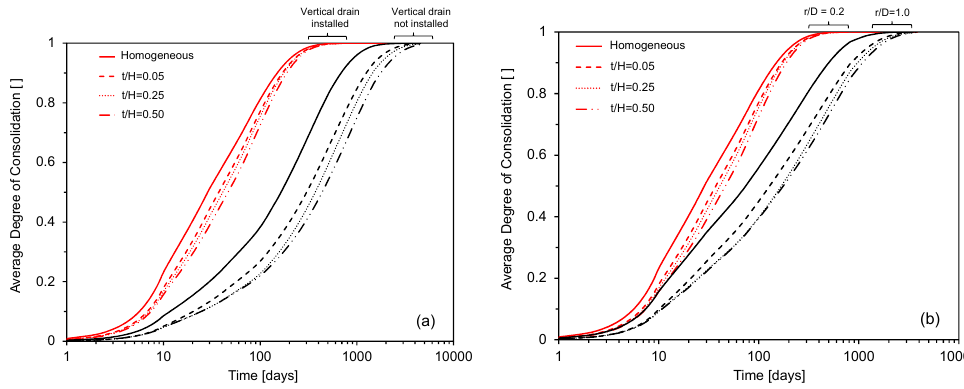
Figure 3. Effect of a vertical drainage conditions on the consolidation of the binary mixtures; ( a ) vertical drain (r/D = 0.2); ( b ) vertical drainage distance. The vertical drain is installed along the centerline and radial drainage is allowed. [k] A /[k] B = 0.2 in all cases. The radial consolidation coefficient is assumed to be identical to the vertical one.